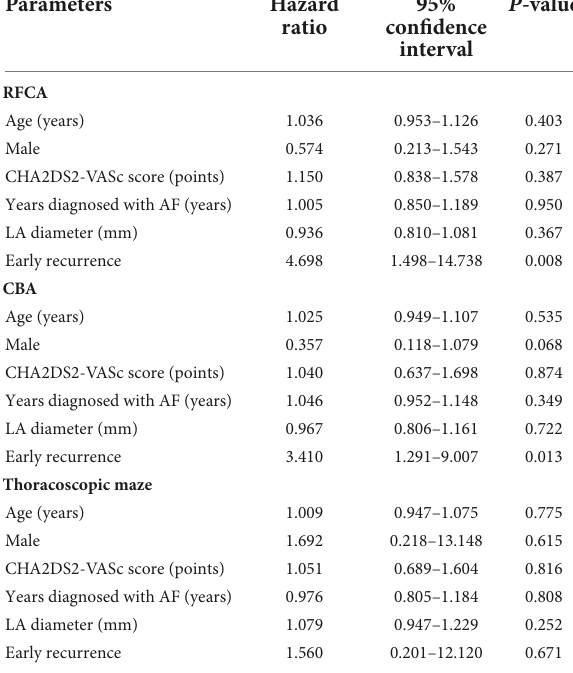
TABLE 2 Cox regression analyses to evaluate prognostic implication of each variable (univariate analysis for RFCA, CBA, and thoracoscopic